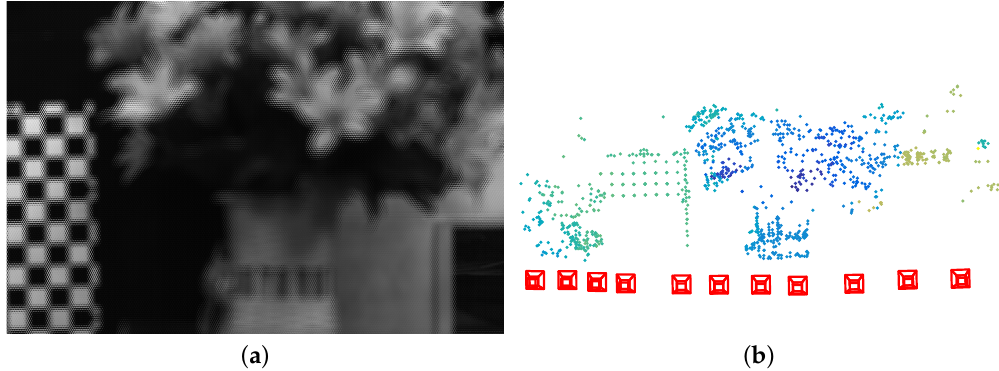
Figure 15. Sparse point cloud reconstruction results based on real data. ( a ) Example of captured raw image (6576 pixel × 4384 pixel). ( b ) Reconstructed sparse point cloud from 11